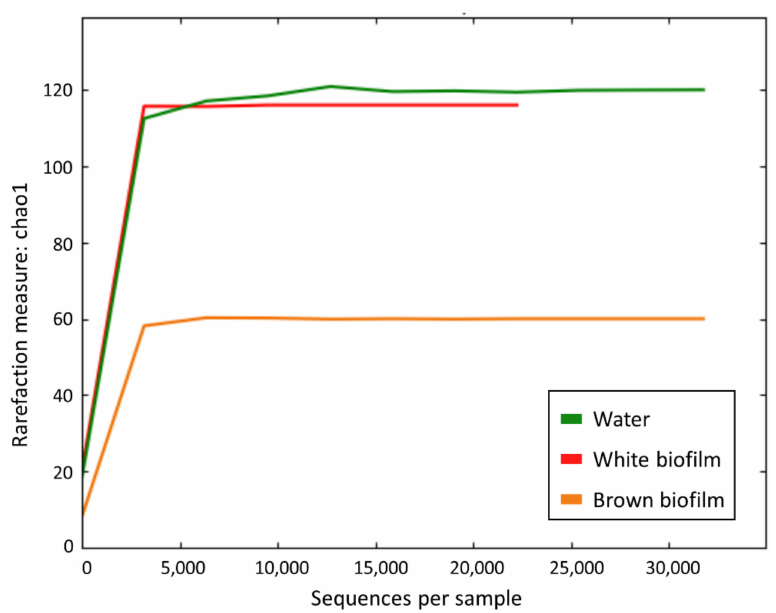
Figure 4. Rarefaction curves based on Chao1 metrics for water, white biofilm, and brown biofilm